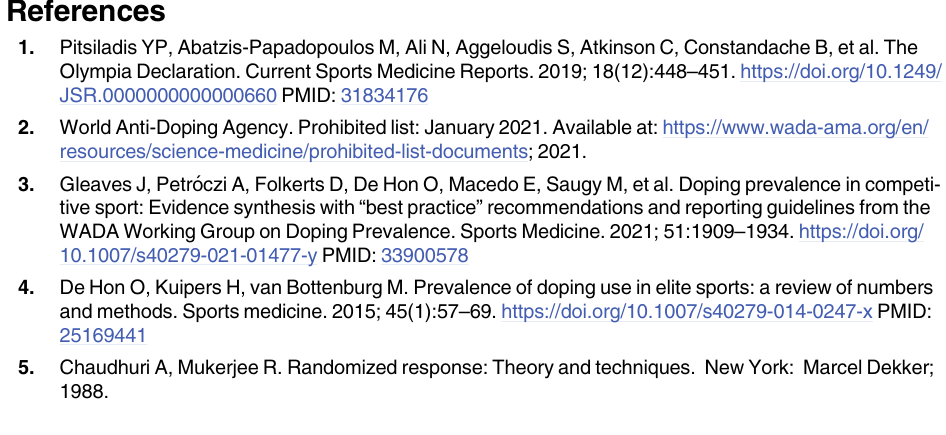
S1 Fig. Power curves of the crosswise model. S2 Fig. Allocation of respondents to experimental conditions.